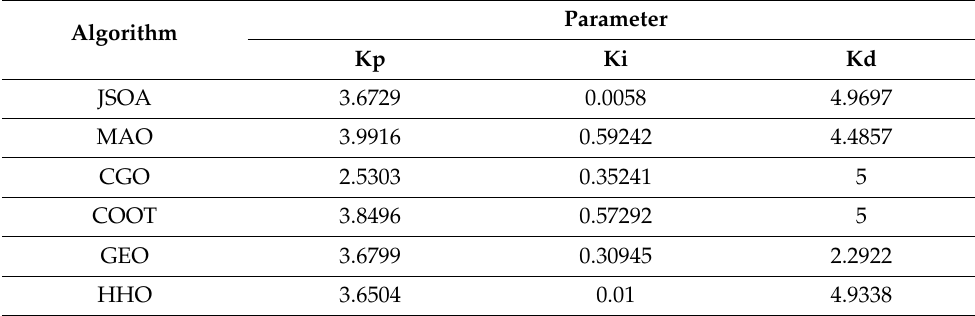
Table 10. Comparison results of optimized PID parameters.